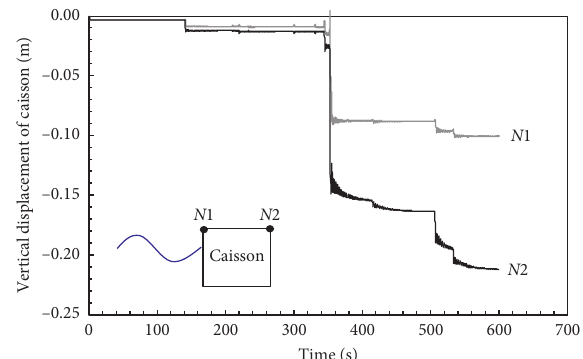
Figure 19: Time history of caisson’s